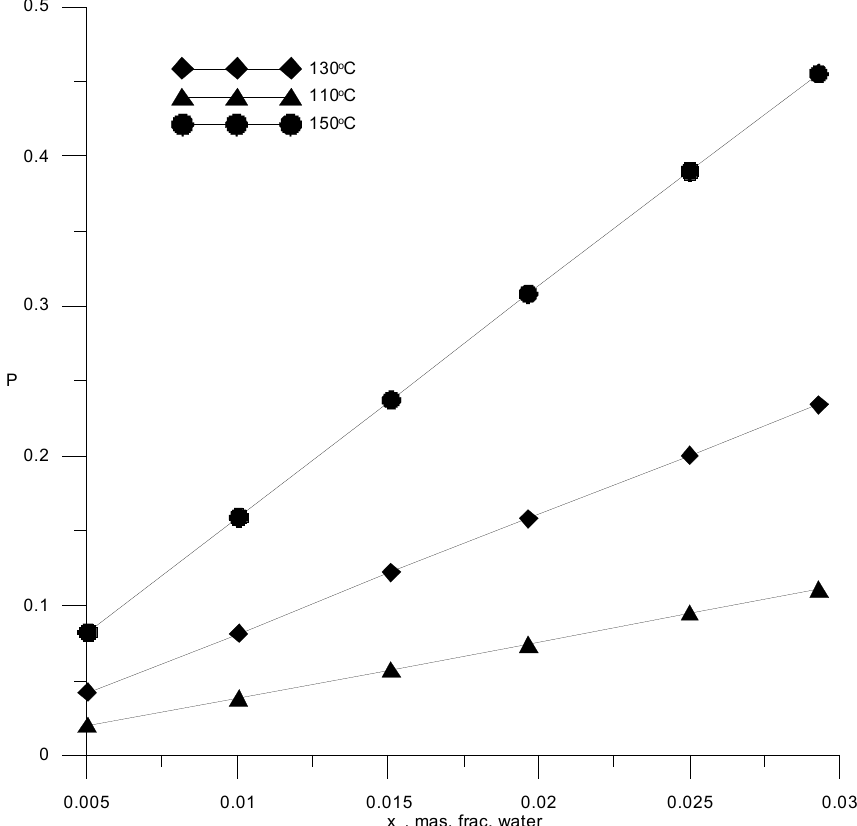
Figure 13. Isotherms of saturated water vapor pressure over a binary water–AEBA-TEG solution, depending on the composition.